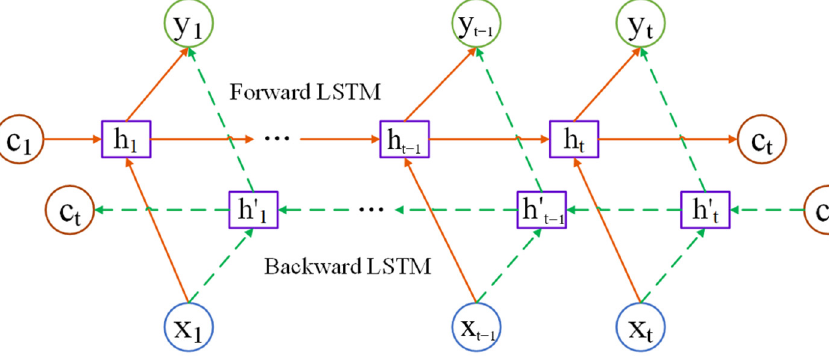
Figure 2. The BiLSTM model structure.